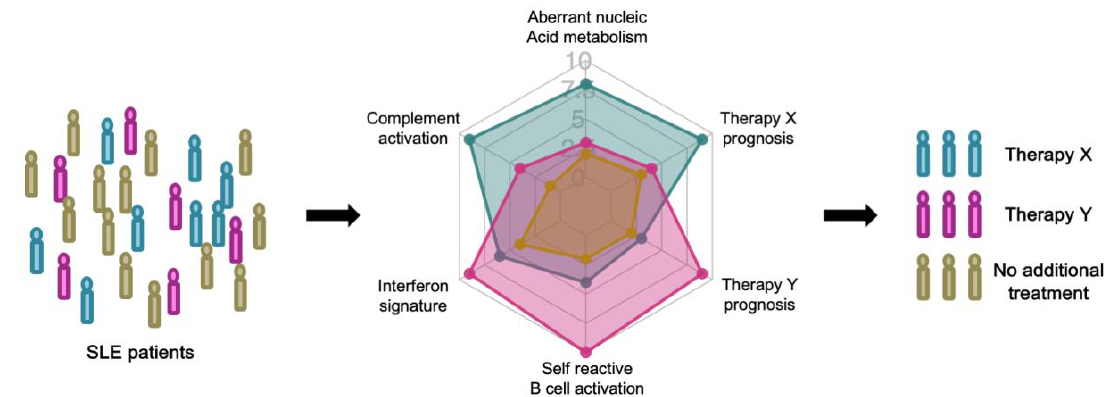
Figure 1. Stratified treatment of systemic lupus erythematosus (SLE) patients based on prognostic and predictive biomarkers.